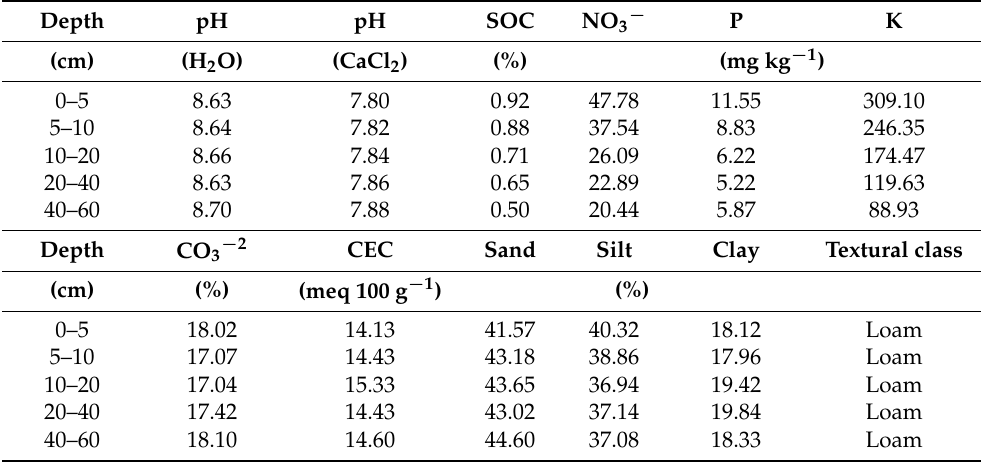
Table 1. Main soil physico-chemical properties of the experimental plot.